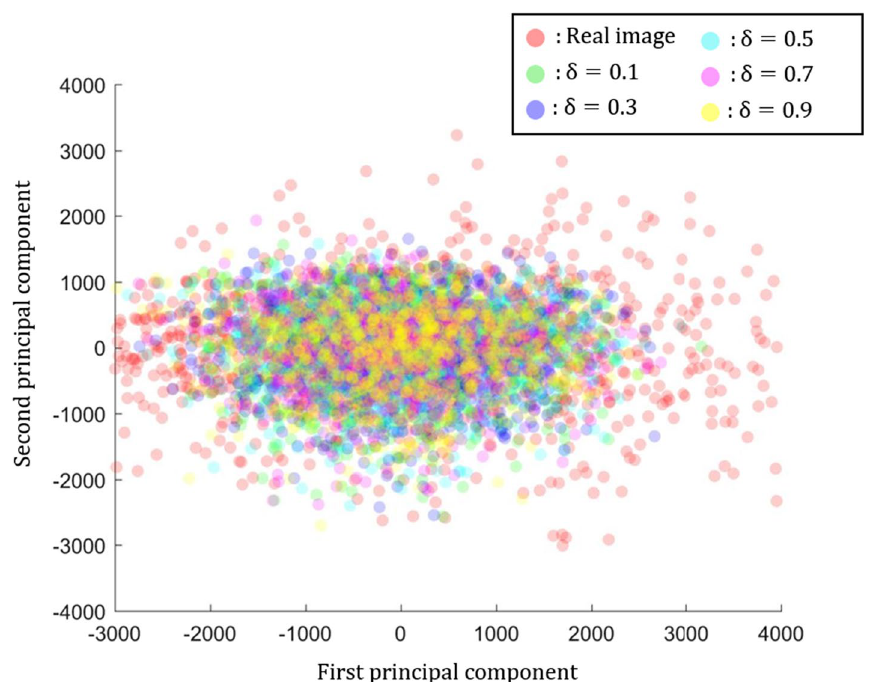
Fig. 7 Data distribution projected onto the first two principal